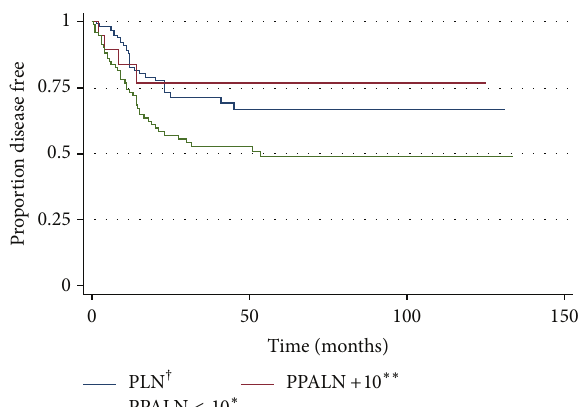
Figure 1: Kaplan-Meier disease-free survival estimate. PPALN < 10 ∗